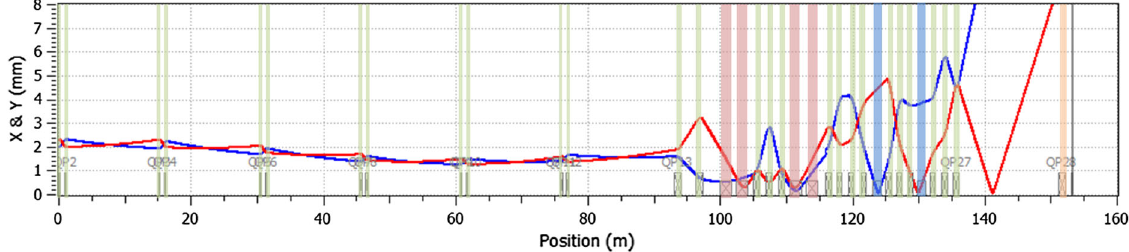
FIG. 2. The horizontal (blue) and vertical (red) 1 rms beam envelopes throughout the HEBT. The colors denote different elements: red for dipoles, green for quadrupoles, blue for octupoles, orange for the fixed collimator, and grey for the proton beam